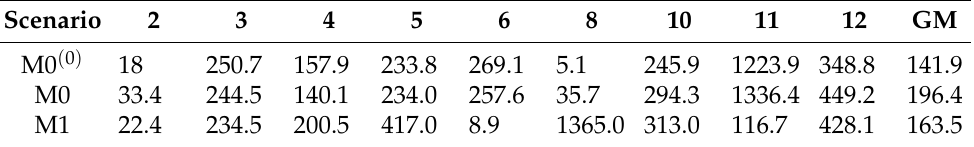
Table 6. Variance between correct selections of MTCs in different locations throughout the combina- tion space. GM is geometric mean. Results are based on 4000